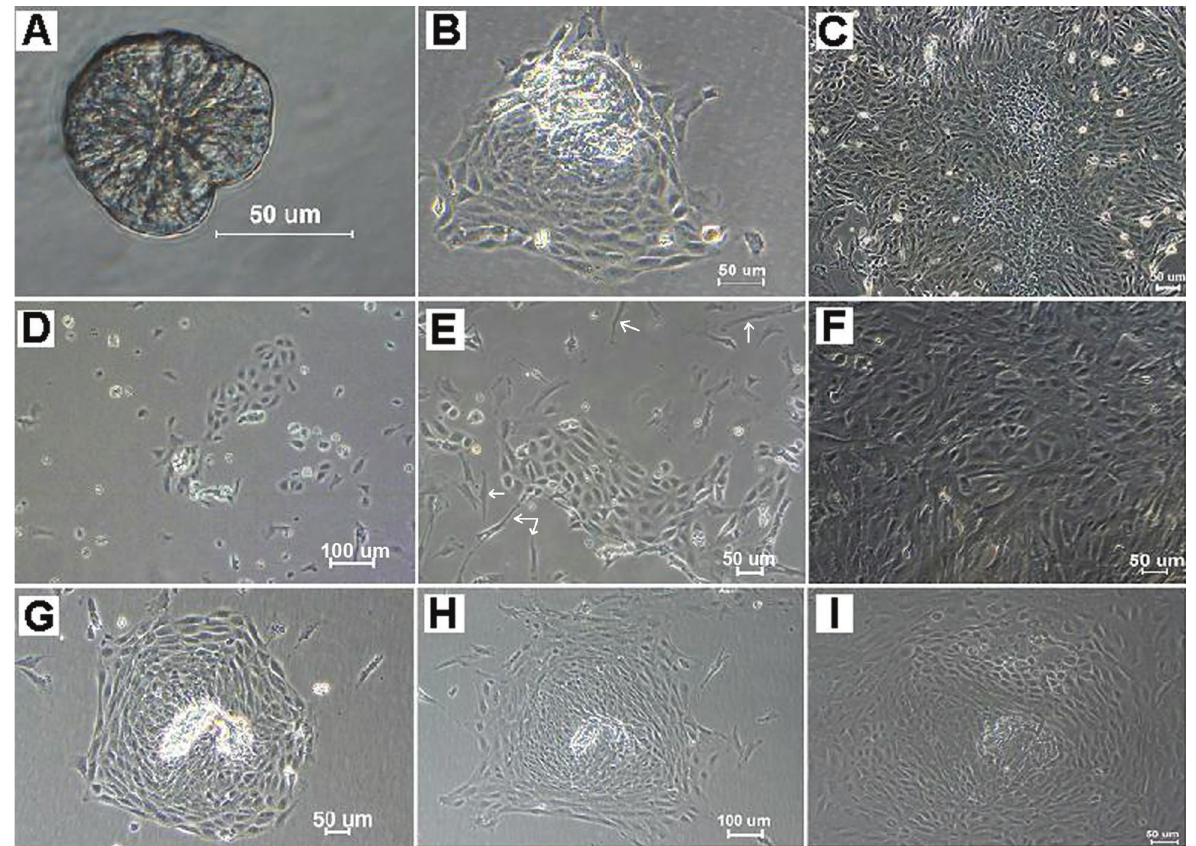
Figure 1. Proliferation of primary-cultured fetal mouse intestinal epithelial cells obtained using different enzymatic methods. Crypts were isolated from fetal mouse intestines using collagenase I/hyaluronidase digestion ( A ). Proliferative epithelial cells gradually migrated out around the crypts within 24 h ( B ), formed large colonies after 5 days ( C) , and continued to spread extensively before con fl uence was reached. While trypsin digestion yielded mostly single cells, only part of epithelial cells were adhesive and grew slowly ( D ). Epithelial cells were mixed with fi broblasts (white arrows), which grew either in groups or scattered ( E , F ). In addition, thermolysin also appeared to give a few crypts, although mostly in single cells. Proliferative epithelial cells migrated outward after 24 h, and spread extensively and formed colonies after culturing for 2 to 6 days ( G , H ). However, the colonies later stopped expanding, and part of those cells began to degenerate after 10 days ( I